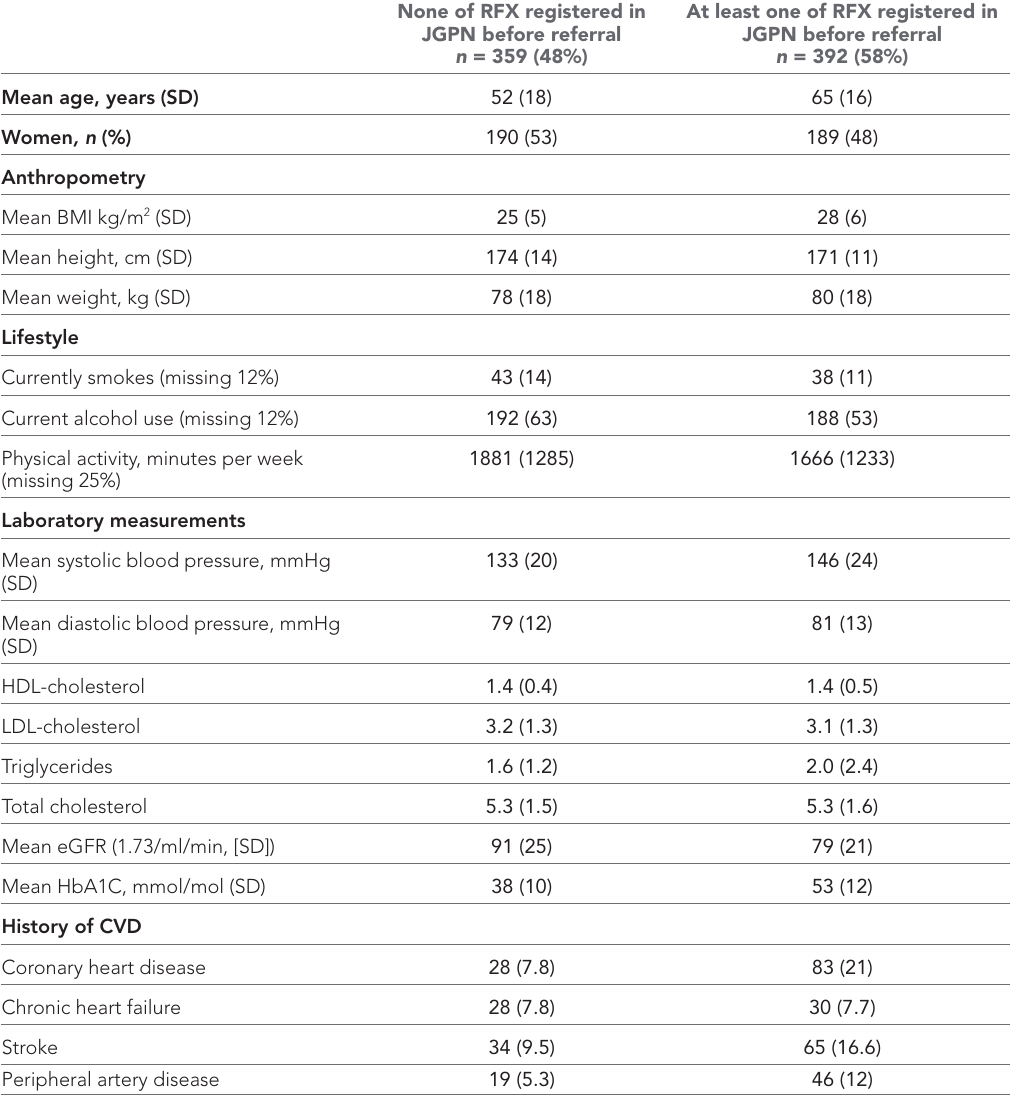
Table 2 Risk factor profile measured at UCC